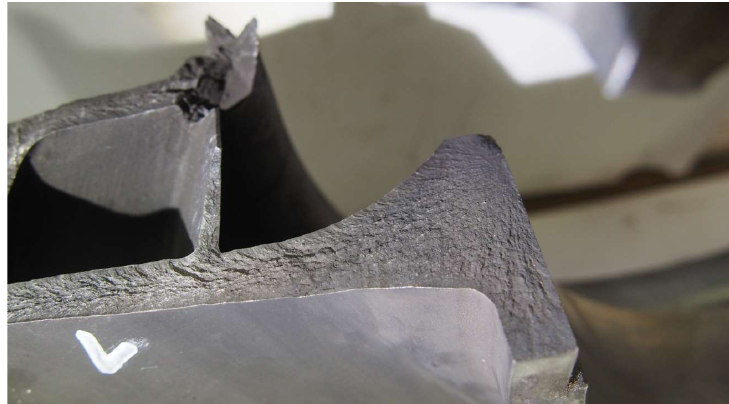
Figure 3. Fracture surface of the damaged impeller.